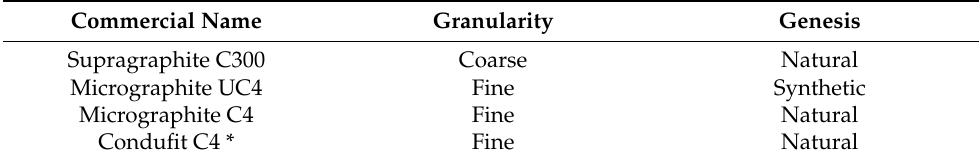
Table 4. Classification of primary fillers.